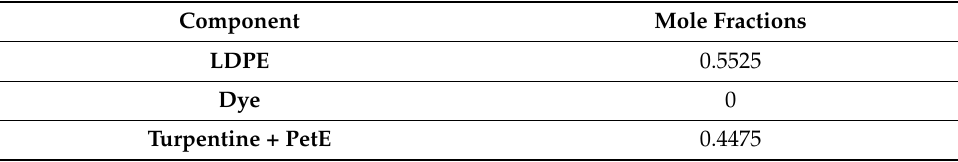
Table 4. Compositions of LDPE, Dye and